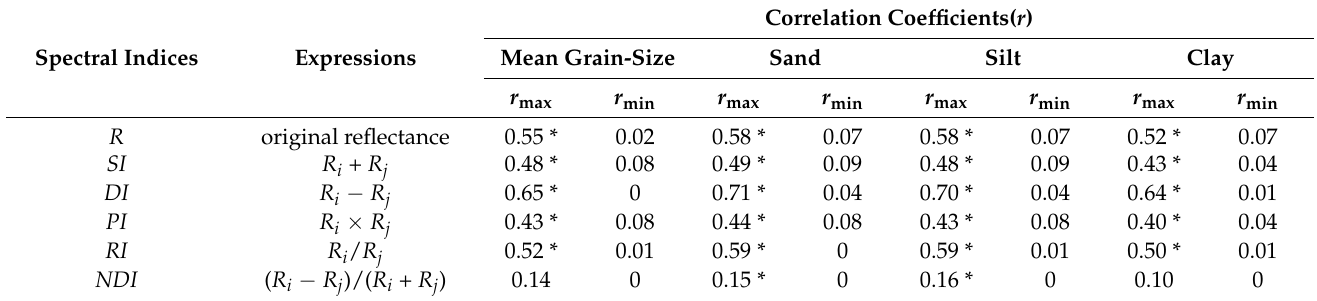
* denotes a significant level ( p < 0.05).